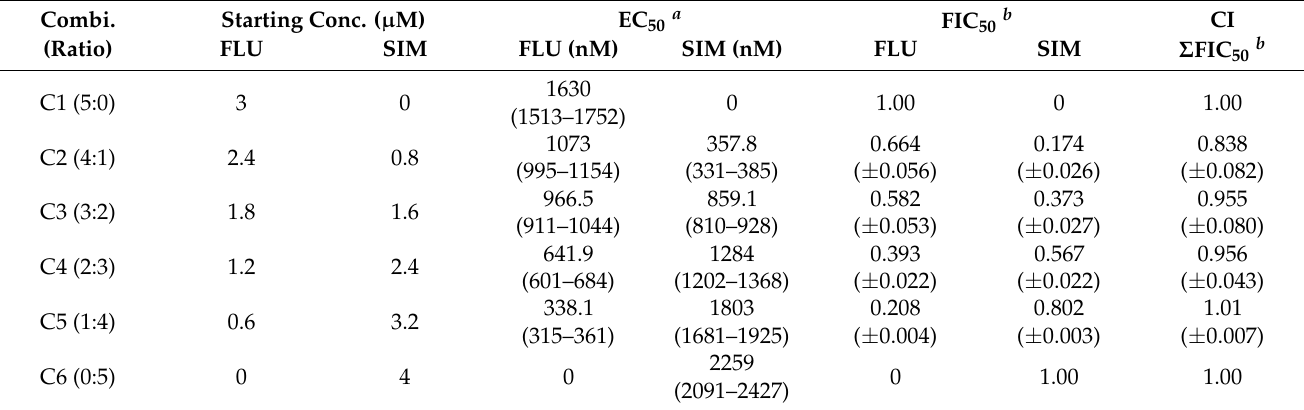
Table 4. Half-maximal inhibitory concentrations for the fluvastatin and simvastatin combinations. Combi.